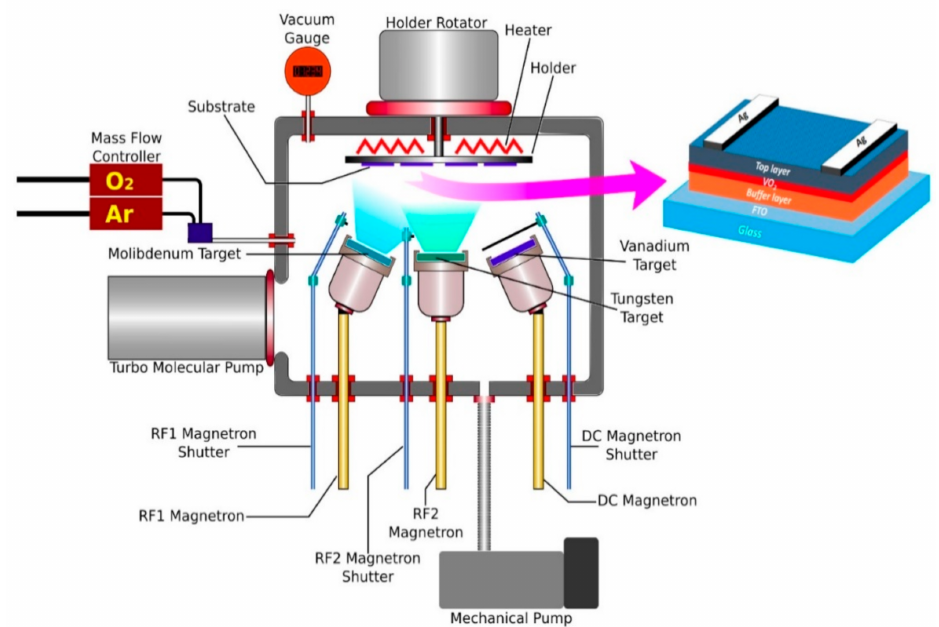
Figure 1. A schematic diagram for the used RF and DC sputtering